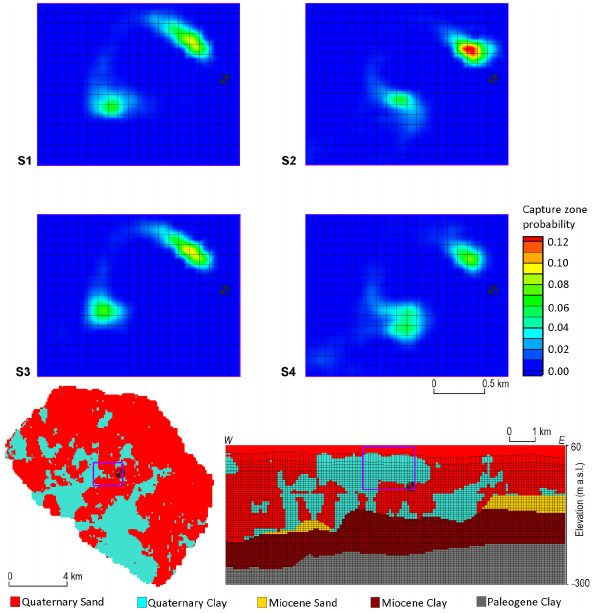
Figure 10: The probabilistic capture zone of Well 2 from each scenario. The well location is 2 Figure 10. The probabilistic capture zone of Well 2 from each sce- illustrated in relation to the geological structure of the TI1. 3 nario. The well location is illustrated in relation to the geological structure of the TI1. Table 4. Estimated hydraulic conductivity of Quaternary sand and Quaternary clay using PEST. The values listed are mean and stan- dard deviations σ of estimated values over 50 realizations of each scenario (unit: md − 1 ).